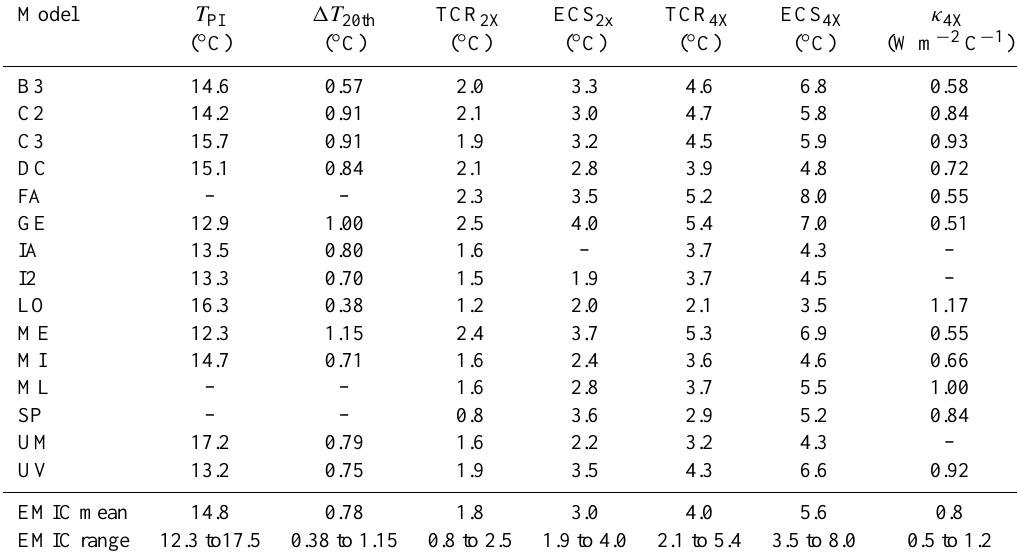
Table 2. Standard metrics that help characterize model response. T PI is the average surface air temperature between 850 and 1750, and 1T 20th is the change in surface air temperature over the 20th century, both from the historical “all” forcing experiment. TCR 2X , TCR 4X , and ECS 4X are the changes in global average model surface air temperature from the decades centred at years 70, 140, and 995 respectively, from the idealized 1% increase to 4 × CO 2 experiment. The ocean heat uptake efficiency, κ 4X , is calculated from the global average heat flux divided by TCR 4X for the decade centred at year 140, from the same idealized experiment. Note that ECS 2x was calculated from the decade centred at about year 995 from a 2 × CO 2 pulse experiment.